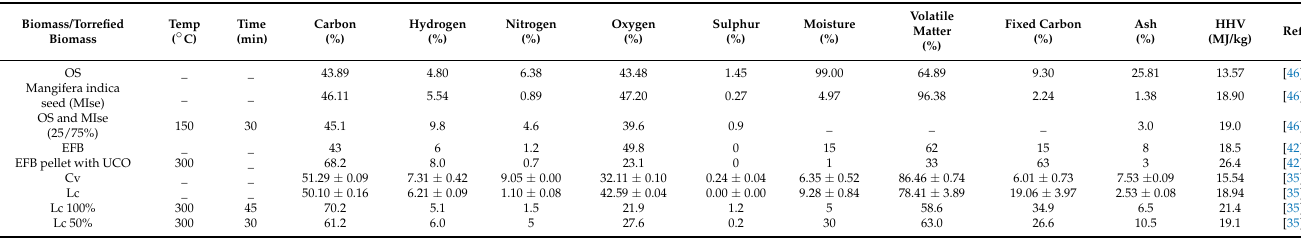
Table 2. Ultimate and proximate analyses of torrefied